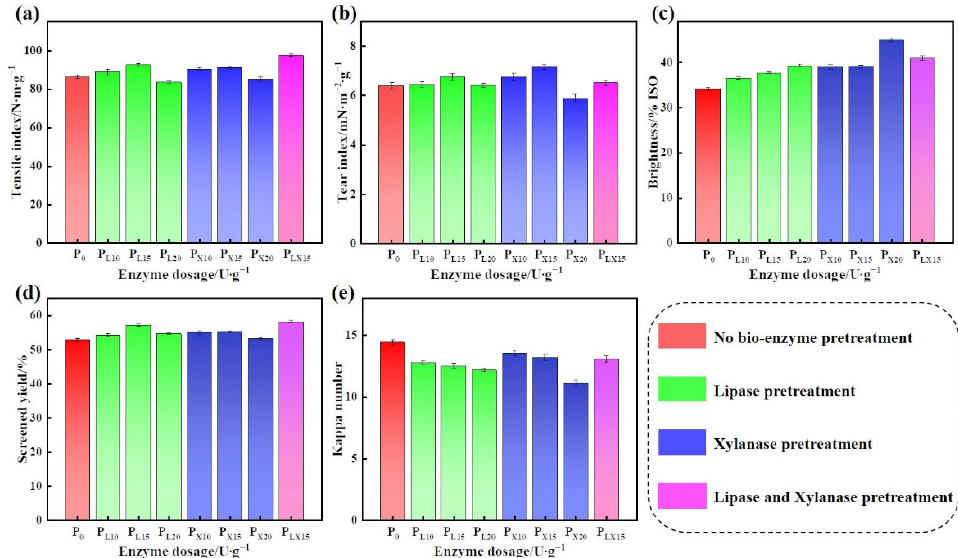
Figure 2. The effect of various bio-enzyme dosage on pulp properties: ( a ) Tensile index; ( b ) Tear index; ( c ) Brightness; ( d ) Screened yield and ( e ) Kappa number.